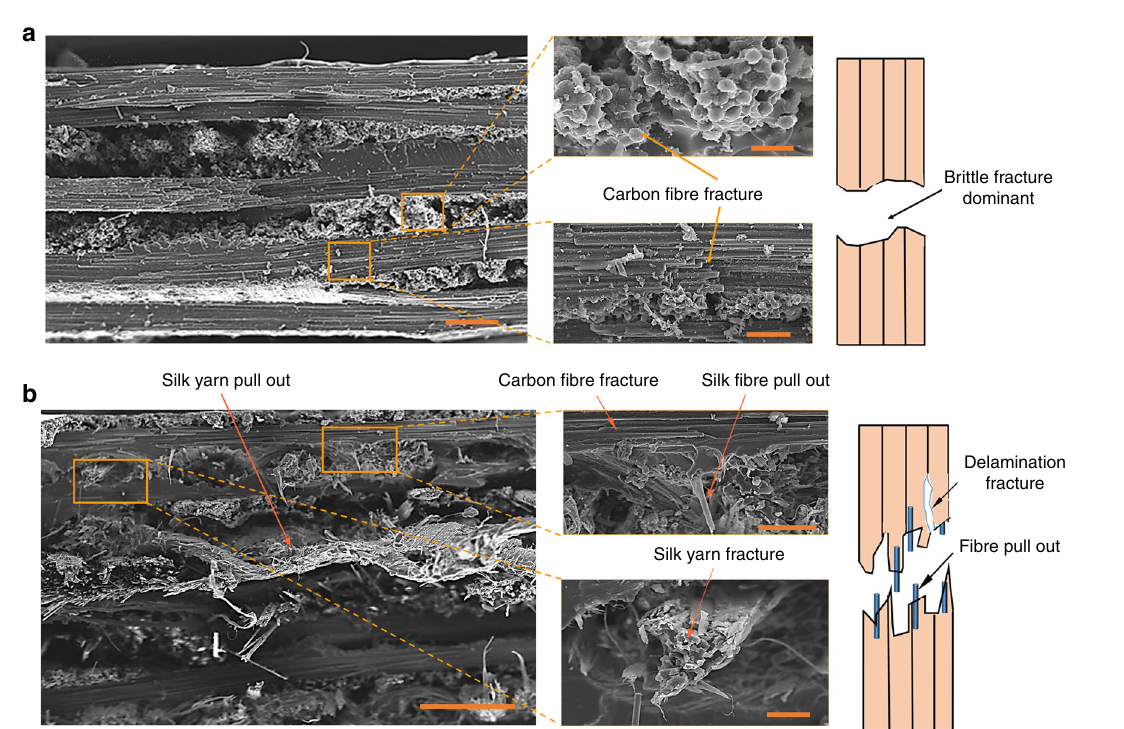
Fig. 3 SEM image and schematic diagram of the tensile fractures. a CFRP, scale bars 200 μ m (left panel), 20 μ m (upper right panel) and 50 μ m (lower right panel); b HFRP 5C5S-1, scale bars 500 μ m (left panel), 100 μ m (upper right panel) and 50 μ m (lower right panel)